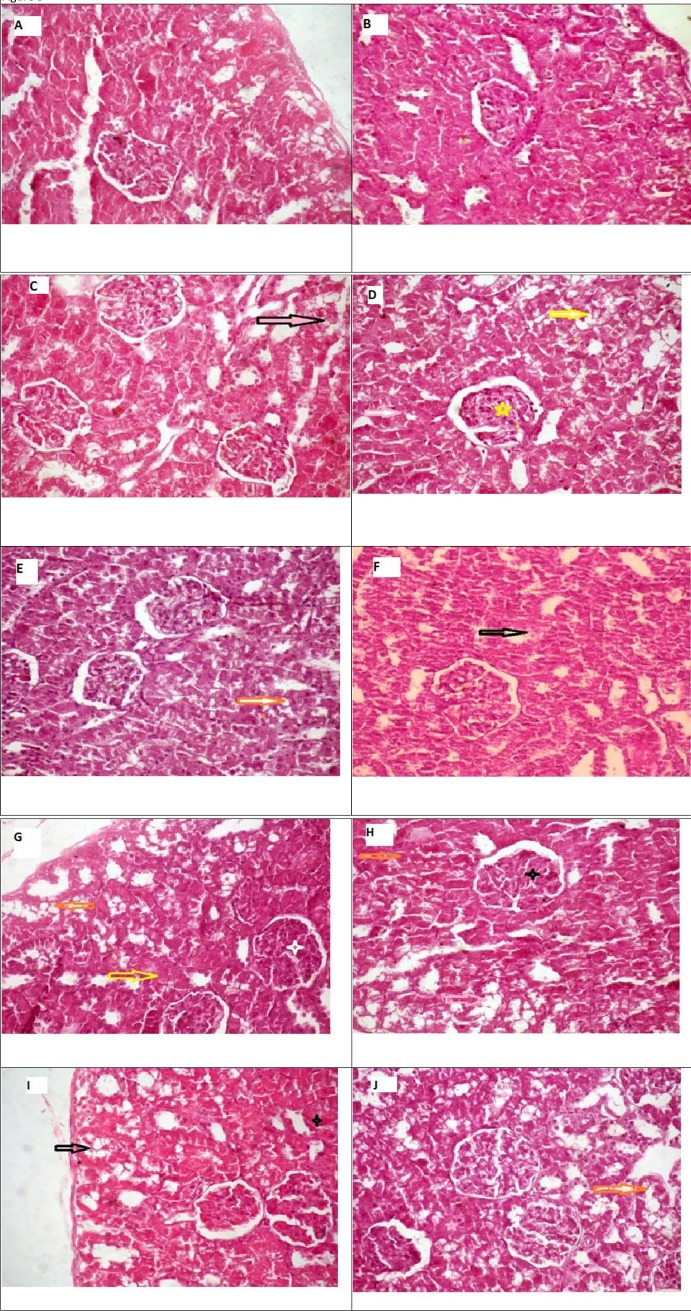
A and B are photomicrographs of kidney sections of the control group that showed normal renal tissues of glomeruli and tubules (H&E 200). Fig 3C is the photomicrograph of kidney section of tramadol-treated group after single dose treatment and showed mild tubular vacuolation (pink arrow) (H&E 400). Fig 3D is the photomicrograph of kidney section of tramadol-treated group after repeated dose that showed moderate tubular vacuolation (yellow arrow), mesongial expansion (yellow star), and cloudy swelling (pink arrow) (H&E 400). Fig 3E is the photomicrograph of kidney section of tramadol + Curcumin after single dose treatment that showed mild tubular vacuolation (orang arrow) (H&E 200). Fig 3F is the photomicrograph of the kidney section of tramadol + Curcumin after repeated-dose treatment that showed mild tubular vacuolation (black arrow). (H&E 200). Fig 3G photomicrograph of kidney section of tramadol + Gallic acid-treated-group that showed mild tubular vacuolation (orange arrow), mesongial expansion and cloudy swelling (yellow arrow) after single dose treatments (H&E 200). Fig 3H is the photomicrograph of kidney section of tramadol + Gallic acid-treated-group that showed mild tubular vacuolation (pink arrow), mesongial expansion (black star) and cloudy swelling (red arrow) after single dose treatments (H&E 200). Fig 3I is the photomicrograph of kidney section of tramadol + Curcumin +Gallic acid-treated group reveals mild tubular vacuolation, and cloudy swelling after repeated dose treatments (H&E 200). Fig 3J is the photomicrograph of kidney section of tramadol + Curcumin +Gallic acid-treated group that showed mild tubular vacuolation (orange arrow) after repeated-dose treatment (H&E 200).